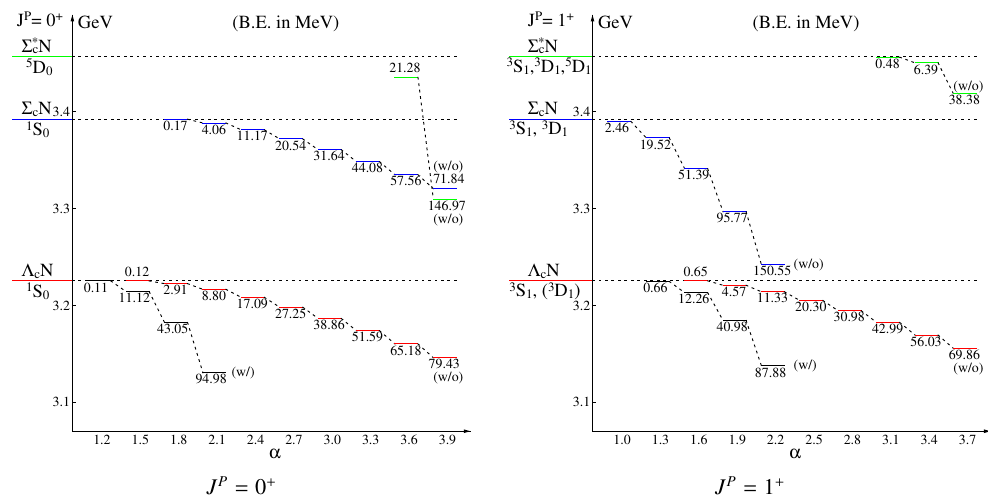
Fig. 4. The sensitivity of the binding energy (B.E.) to the parameter α in the OBEP model for the J P = 0 + and J P = 1 + cases. The cases without (w / o) and with (w / ) channel coupling are both shown. ( 3 D 1 ) means there is no S − D mixing when one considers only the Λ c N channel.